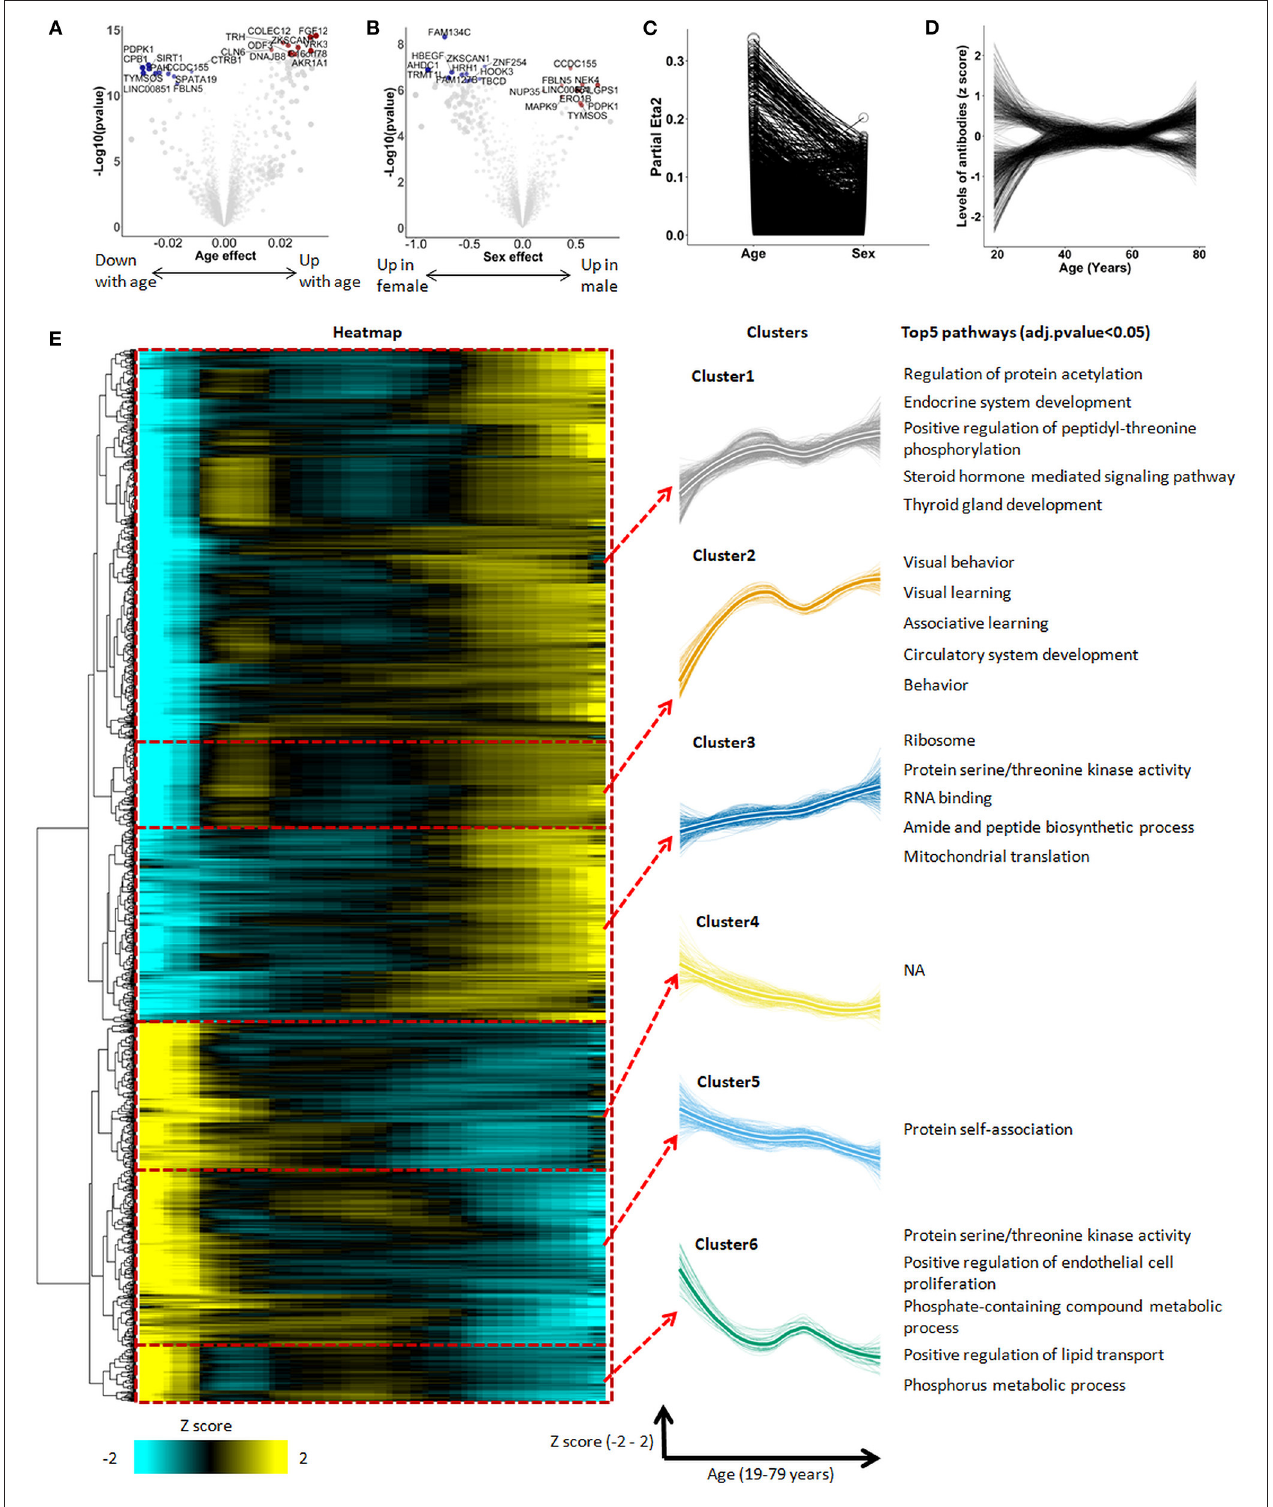
FIGURE 1 | The autoimmunomic signature of aging identified by linear modeling. In total, serum levels of IgG autoantibodies against 9,256 human antigens were analyzed using linear models. Volcano plots representing changes of the autoimmunome with sex (A) and age (B) . Dot sizes are proportional to the product of –log10( p -value) and sex or age effect (beta of the linear model). (C) Relative percentage of variance explained by age and sex, where partial Eta2 is calculated for age and sex. Values for each autoantibodies are connected by edges. (D) Autoantibody trajectories during aging. Levels of 1,276 aging-associated IgG